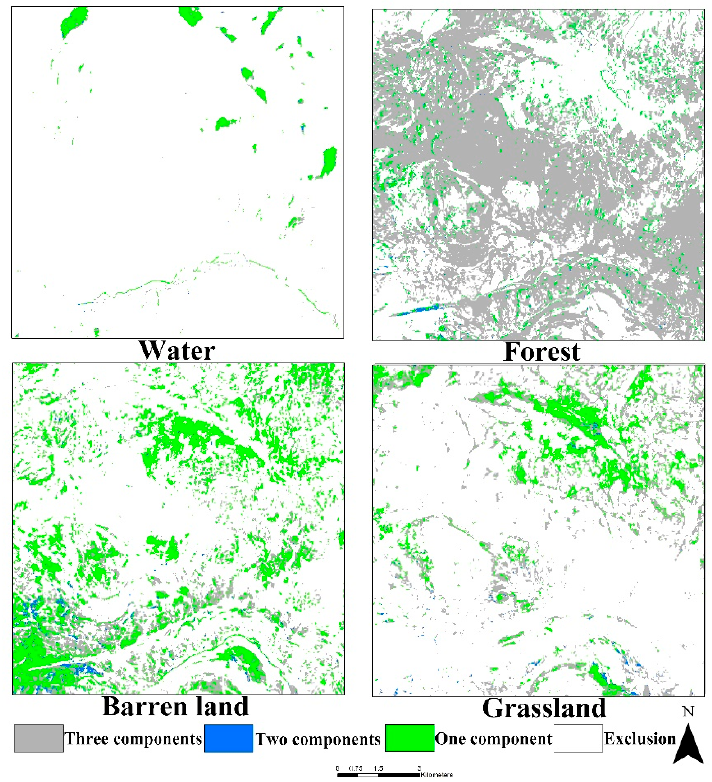
Figure 6. The sub-model preference for each land cover.